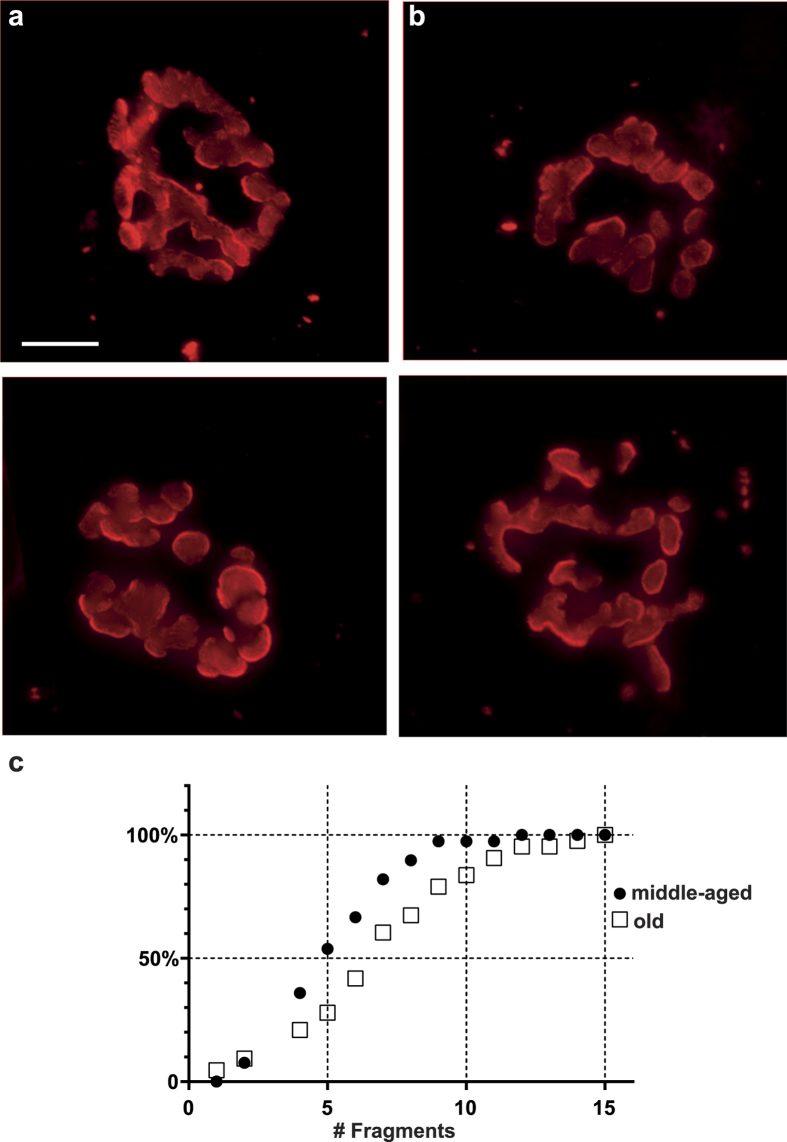
Appearance of NMJs in middle-aged and old mice.(a) Images of middle-aged NMJs (top: 6 fragments, bottom: 7 fragments). (b) Images of old NMJs (top: 11 fragments, bottom: 10 fragments). Scale bar = 12.5 μm. (c) cumulative histograms of the number of fragments present at NMJs in middle-aged mice (solid symbols) and old mice (open symbols).